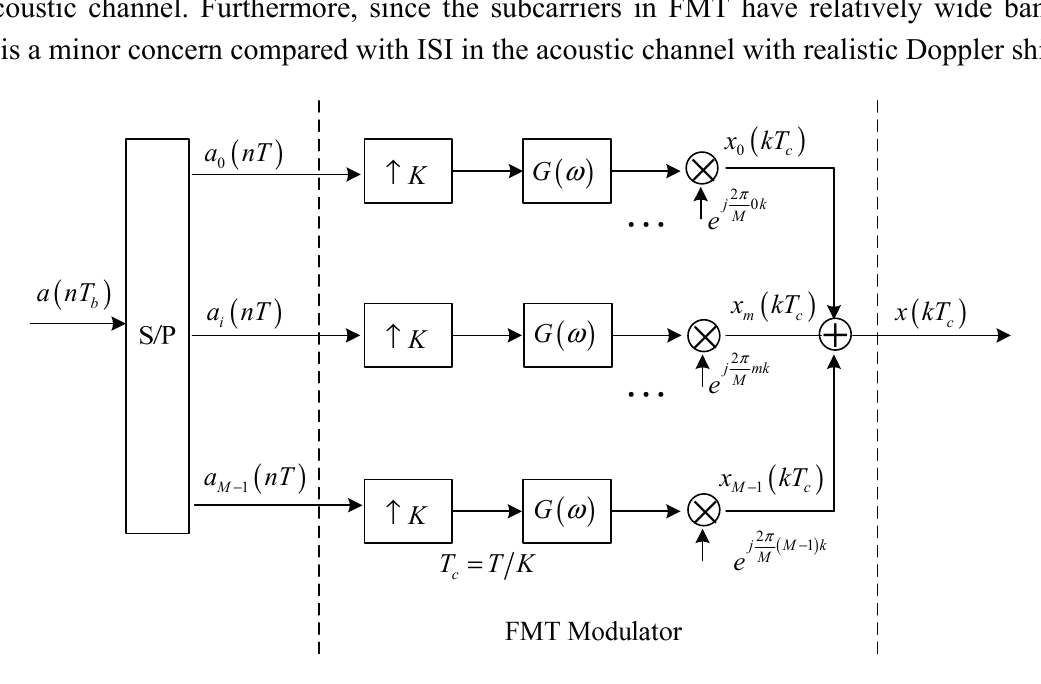
Figure 1. Block diagram for the transmit structure of the proposed method.